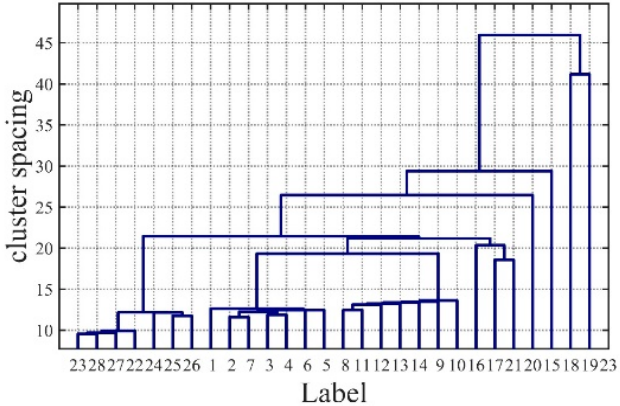
8 of 17 Figure 3. Data training set hierarchical cluster tree and cluster distance folding line change diagram. ( a ) Combination A Stokes dataset ( b ) Combination B Stokes and DOLP dataset ( c ) Combination C Stokes, DOLP, and pBRDF matrix element dataset ( d ) Combining hierarchical cluster distance fold- ing line change diagram with data. The next step is to calculate the standardized Euclidean distance between all data points to form a square matrix, and set the diagonal to INF(infinity). If the distance be- tween two points is less than the cluster distance threshold, it is established that they are